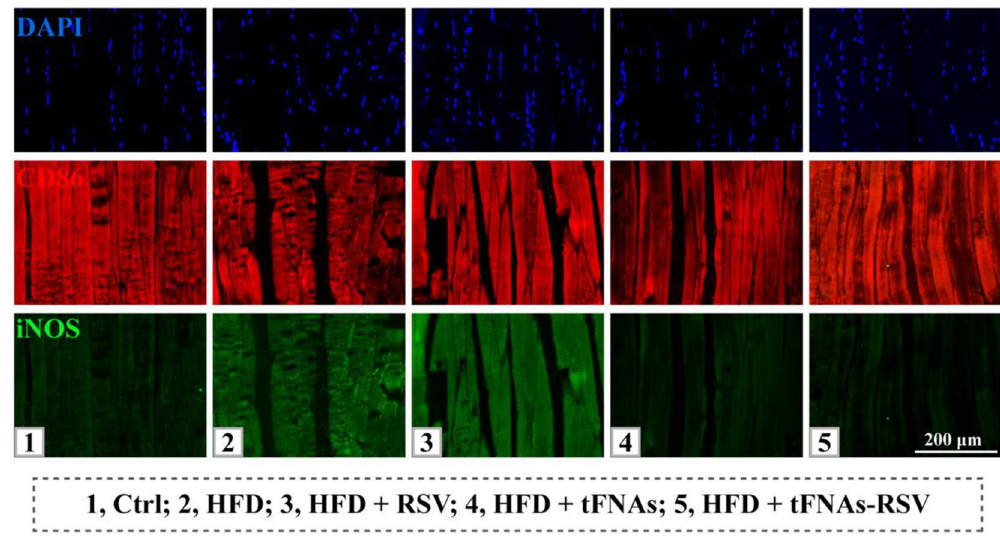
Fig . S16. Tissue immunofluorescence staining of CD68 and iNOS in muscle. Scale bar: 200